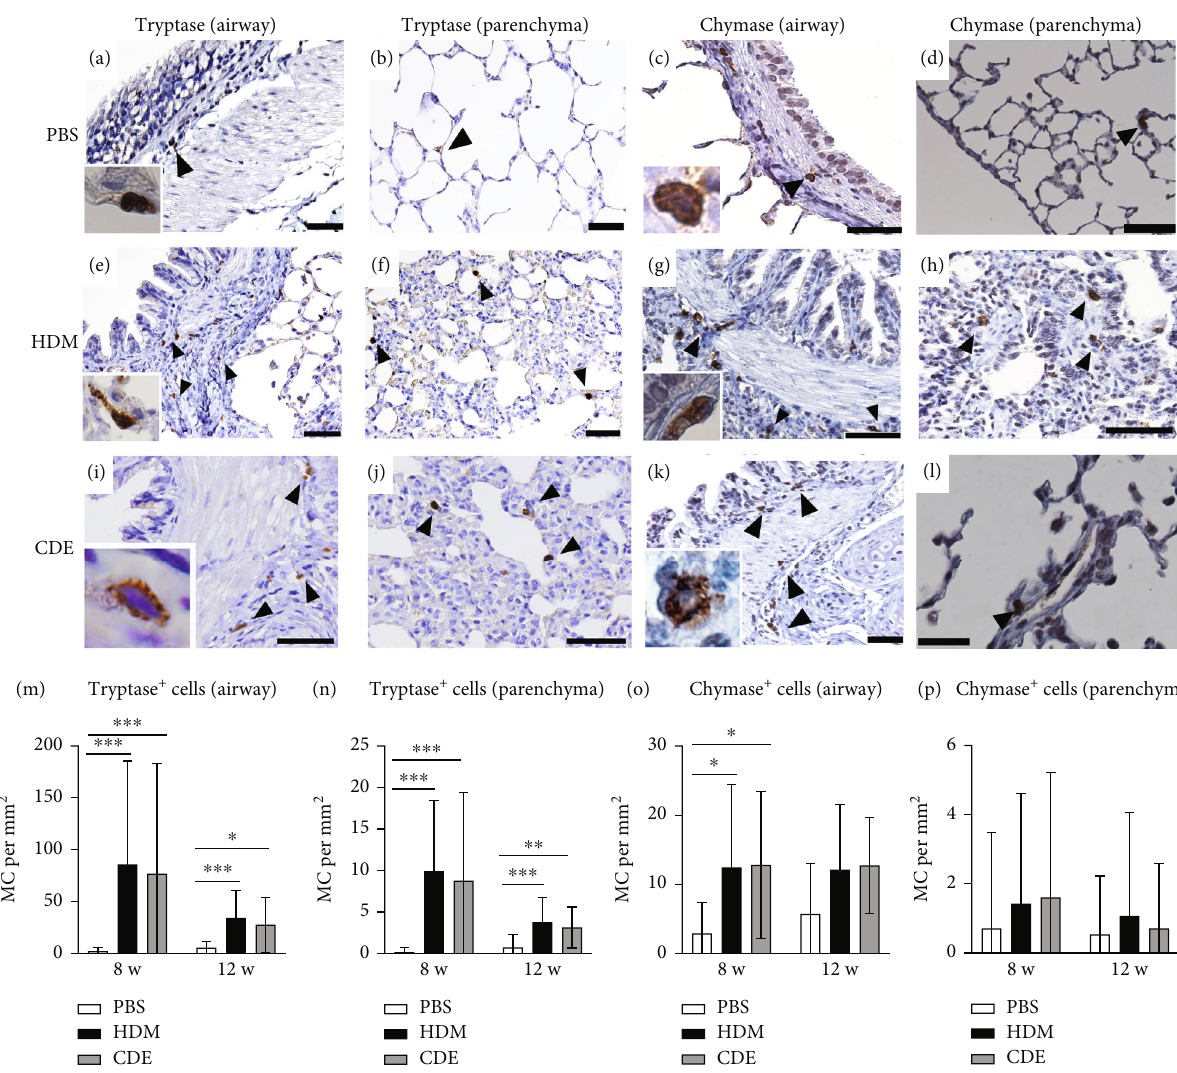
Figure 6: Repetitive allergen exposure induces a marked accumulation of mast cells in guinea pig airways and parenchyma as detected with immunohistochemical staining against tryptase and chymase. Micrographs of immunohistochemical staining of tryptase (a, b, e, f, i, and j) and chymase (c, d, g, h, k, and l) in airways and parenchyma, 8 weeks after challenge. PBS-treated animals (a – d); HDM (e – h); CDE (i – l). Quanti fi cation of tryptase-positive MCs in bronchi (m) and alveolar parenchyma (n) and chymase-positive MCs in bronchi (o) and alveolar parenchyma (p) expressed as MC per mm 2 . Three airways and fi ve fi elds of view of parenchyma (20x magni fi cation) were quanti fi ed per animal. Data are mean ± SD of n = 4 -5 animals per group. ∗ P < 0 : 05 , ∗∗ P < 0 : 01 , and ∗∗∗ P < 0 : 001 . Scale bar: 50 μ m. High magni fi cation micrographs (60x) are shown as inserts in (a, c, e, g, i, and k). HDM: house dust mite extract; CDE: cat dander